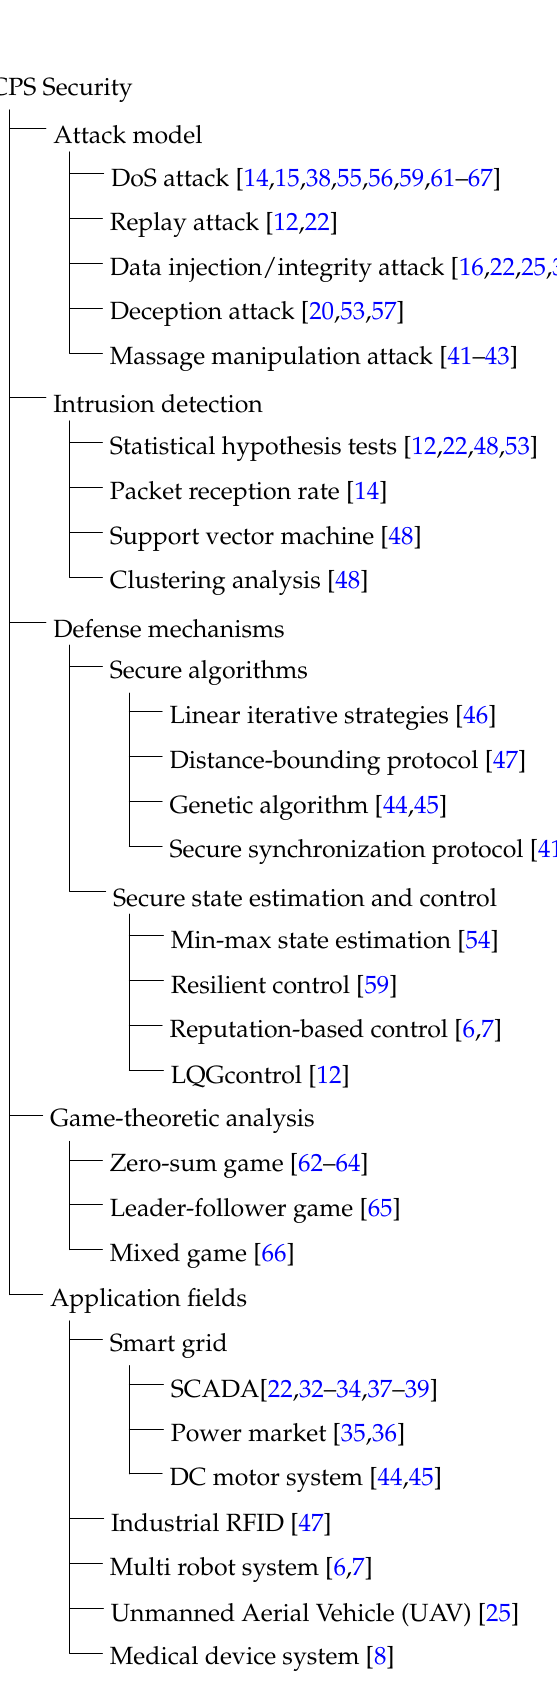
Figure 2. A summary of Cyber-Physical System (CPS)